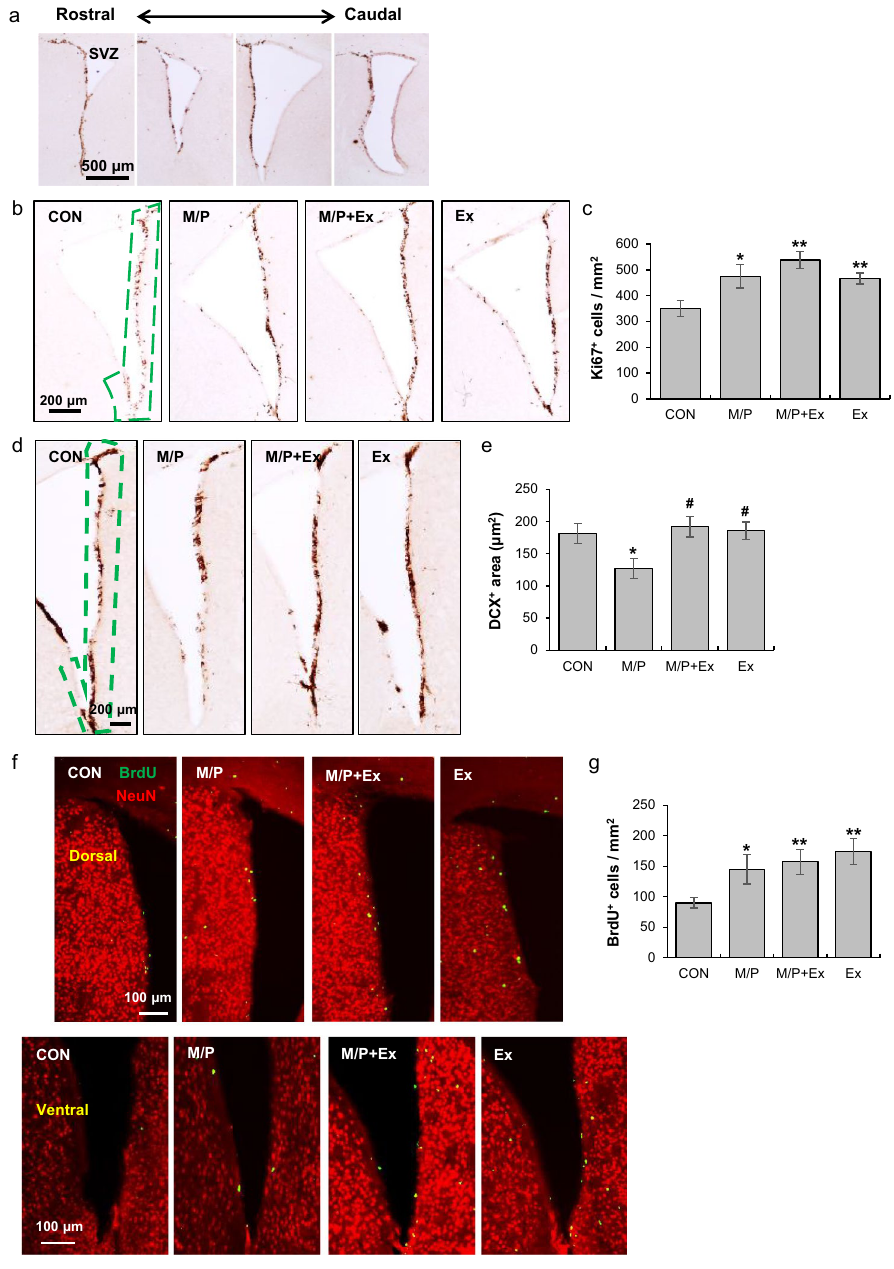
Figure 2. Rotarod walking exercise reduced the deficits of neuronal differentiation in the SVZ region of M/P- treated mice. ( a ) Photomicrographs of the SVZ areas analyzed by histological analysis (40 × of magnification). ( b ) Photomicrographs of the immunoreactivity of SVZ Ki67 + cells (CON, N = 6; M/P, N = 7; M/P + Ex, N = 7; Ex, N = 6, 40 × of magnification). ( c ) Quantification of the immunoreactivity of SVZ Ki67 + cells showing that M/P and exercise increased the number of Ki67 + cells. ( d ) Photomicrographs of the immunoreactivity of SVZ DCX + cells (CON, N = 6; M/P, N = 7; M/P + Ex, N = 7; Ex, N = 6, 40 × of magnification). ( e ) Quantification of the immunoreactivity of SVZ DCX + cells showing that exercise restored the M/P-induced decrease in DCX + cells. ( f ) Photomicrographs of the double fluorescent staining of SVZ BrdU + and NeuN + cells (CON, N = 8; M/P, N = 9; M/P + Ex, N = 9; Ex, N = 8, 100 × of magnification). ( g ) Quantification of the fluorescent staining of SVZ BrdU + cells showing that M/P and exercise increased the number of BrdU + cells. Data are presented as mean ± SEM. *p < 0.05, vs. CON; **p < 0.01, vs. CON; # p < 0.05, vs. M/P. DCX,